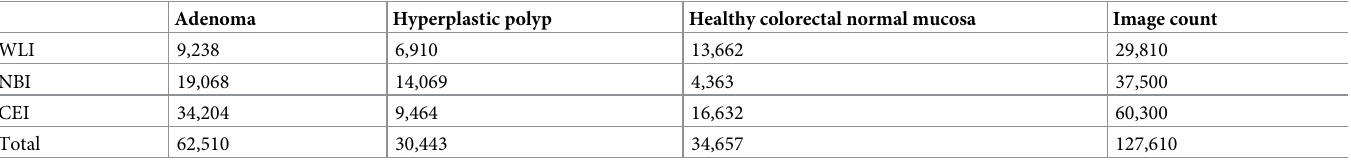
Training data set in 146 patients Adenoma: 74 patients; Hyperplastic polyp: 72 patients Healthy colorectal normal mucosa: surrounding mucosa of adenoma or hyperplastic